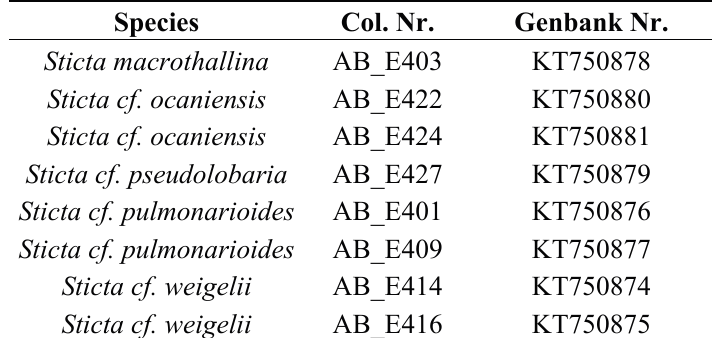
Table 4. Samples used for the molecular phylogeny in this study including GenBank accession